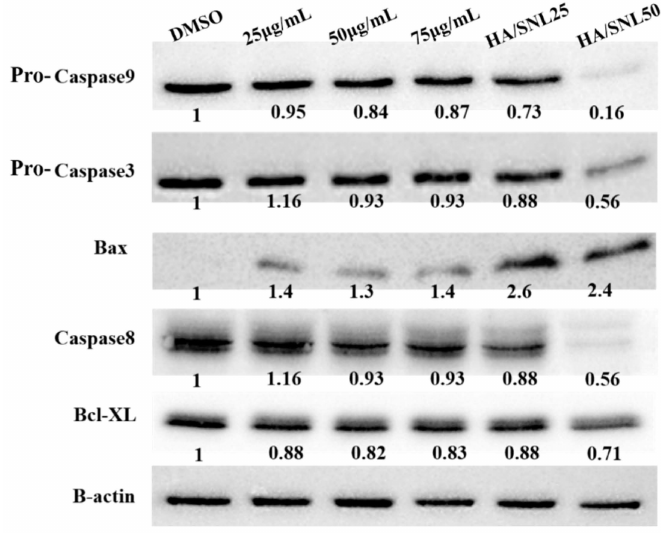
Figure 11. Western blot analysis for detecting apoptosis-related proteins after a 12-h treatment with DMSO, SNL, and HA/SNL